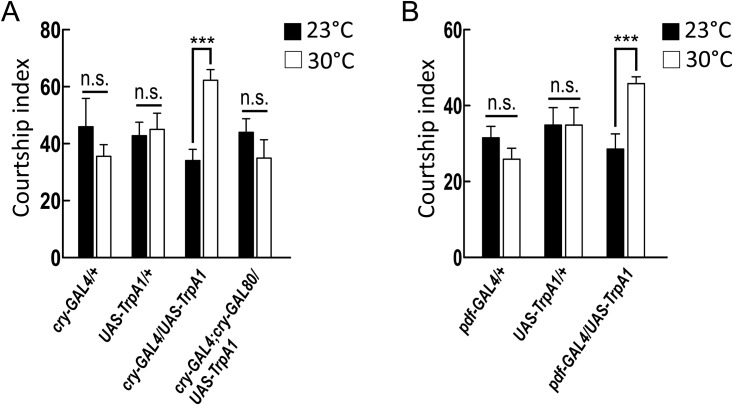
Activating large ventral lateral neurons (l-LNvs) and small ventral lateral neurons (s-LNvs) increases male courtship activity.(A) Activation of cry-GAL4-expressing neurons increased the male courtship index, whereas cry-GAL80 suppressed this behavioral phenotype. Each value represents the mean + SEM (n ≥13; ***p < 0.001; n.s., not statistically significant; t-tests). Genotypes: (1) w/Y; cry-GAL4/+; +/+, (2) w/Y; +/+; +/UAS-TrpA1, (3) w/Y; cry-GAL4/+; +/UAS-TrpA1, (4) w/Y; cry-GAL4/+; cry-GAL80/UAS-TrpA1. (B) Activation of pdf-GAL4-expressing neurons increased the male courtship index. Each value represents the mean + SEM (n ≥ 8; ***p < 0.001; n.s., not statistically significant; t-tests). Genotypes: (1) w/Y; pdf-GAL4/+; +/+, (2) w/Y; +/+; +/UAS-TrpA1, (3) w/Y; pdf-GAL4/+; +/UAS-TrpA1.